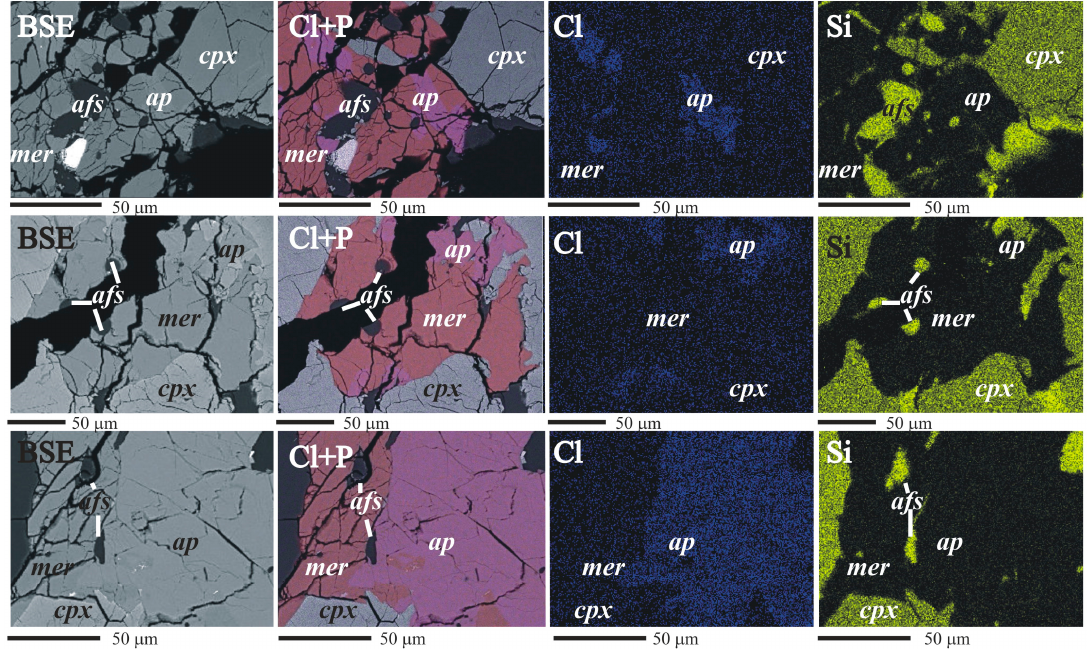
Figure 2. Apatite/merrillite relationship elemental maps (cpx, clinopyroxene; mer, merrillite; ap, apatite; afs, alkali feldspar).